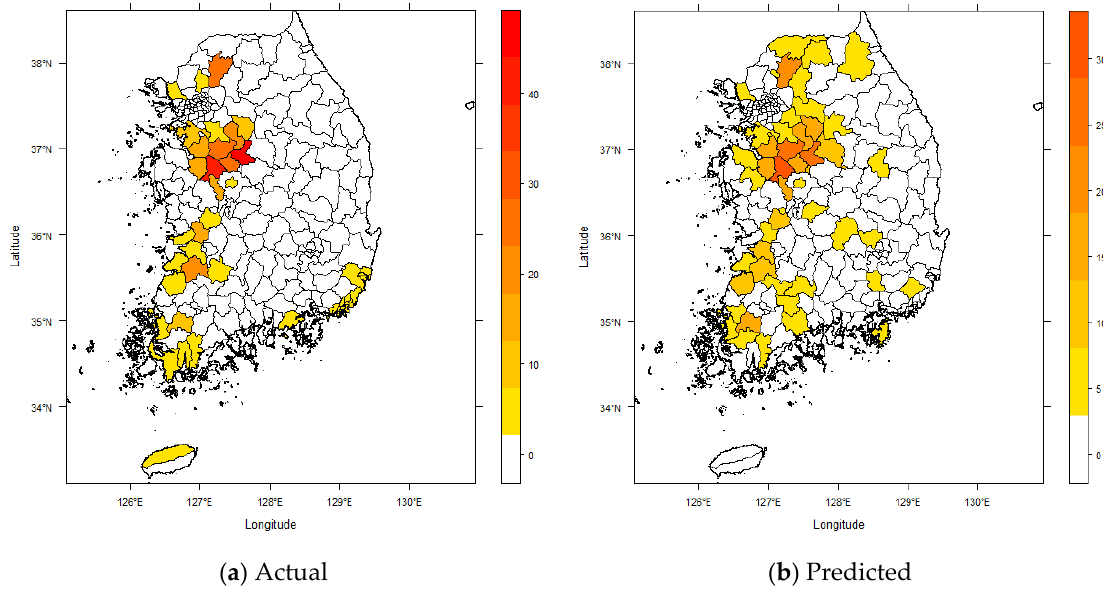
Figure 2. Distribution of the number of farms affected by HPAI ( a ) actual vs. ( b ) predicted using the general spatial model.